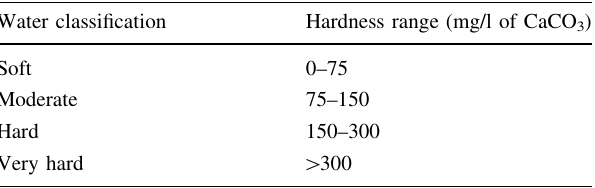
Table 5 Classification of water hardness (Sawyer and Mc Carty 1967) Water classification